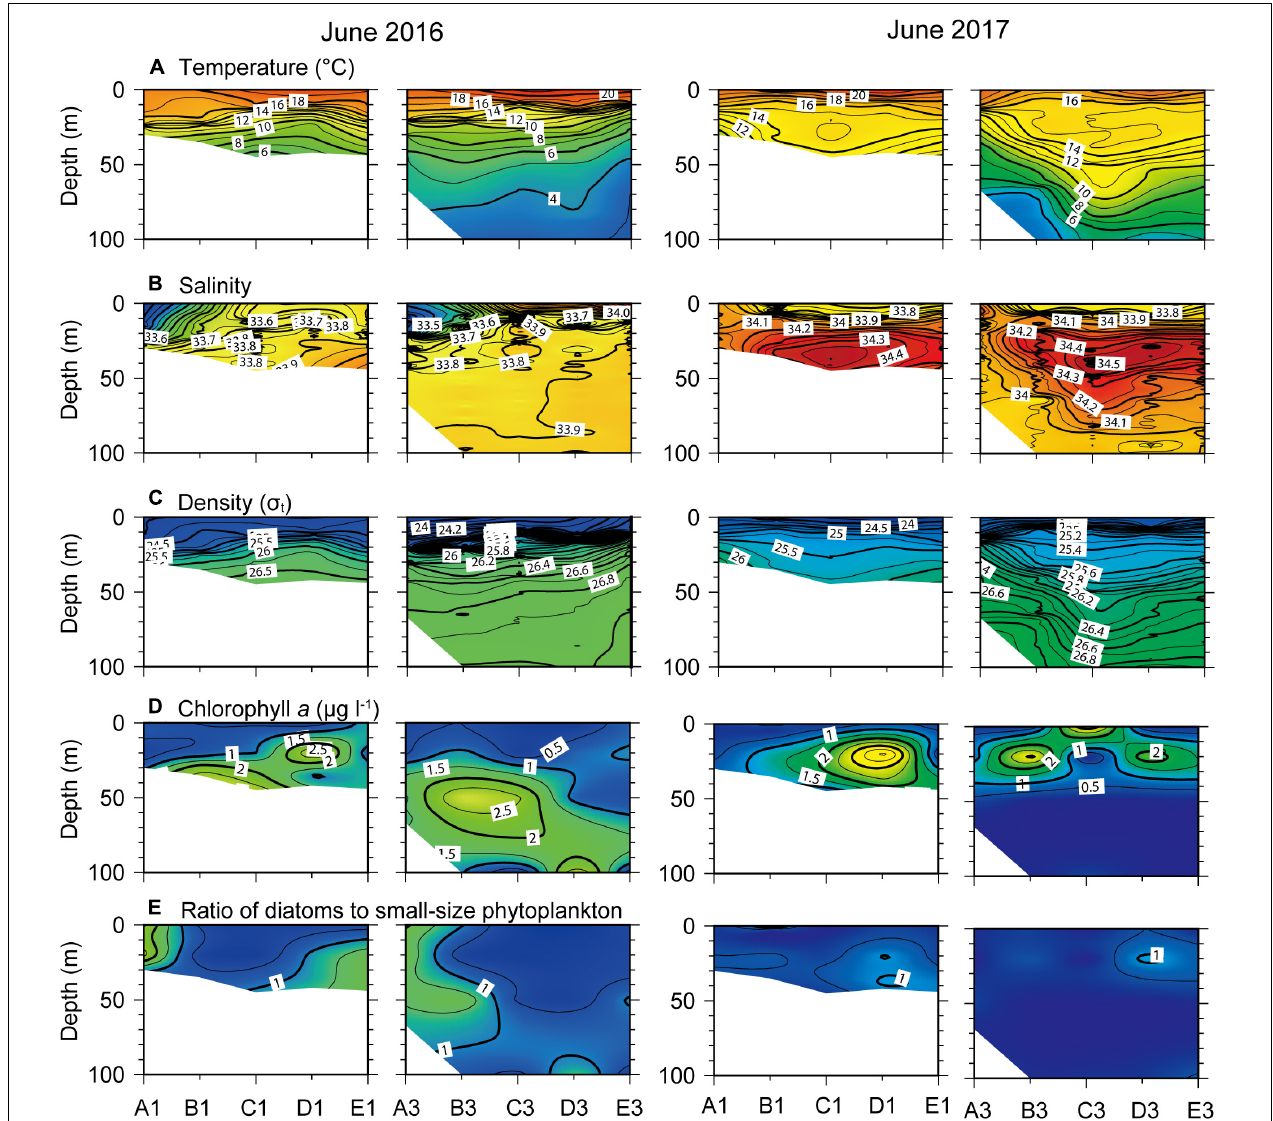
FIGURE 6 | Vertical profiles of (A) temperature, (B) salinity, (C) density, (D) chlorophyll a concentration, and (E) ratio of diatoms to small-sized ( < 20 µ m) phytoplanktons across north–south longitudinal transects of the nearshore (left) and offshore (right) stations (see Figure 1 ) in June 2016 and